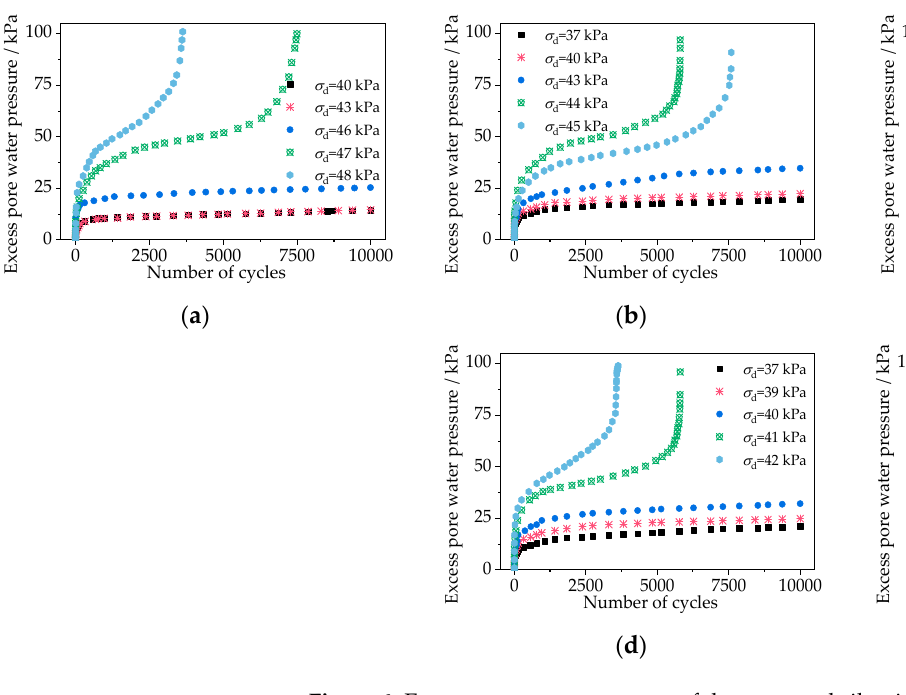
Figure 6. Excess pore water pressure of the saturated silt with different fine particle contents under undrained conditions. ( a ) 7% fine particle content; ( b ) 8% fine particle content; ( c ) 10% fine particle content; ( d ) 12% fine particle content; ( e ) 14% fine particle content.